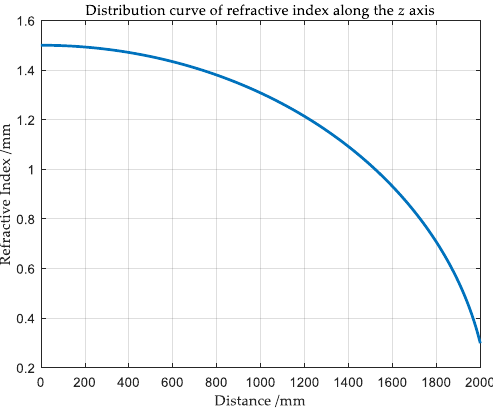
Figure 4. Distribution curve of the refractive index along the z axis.